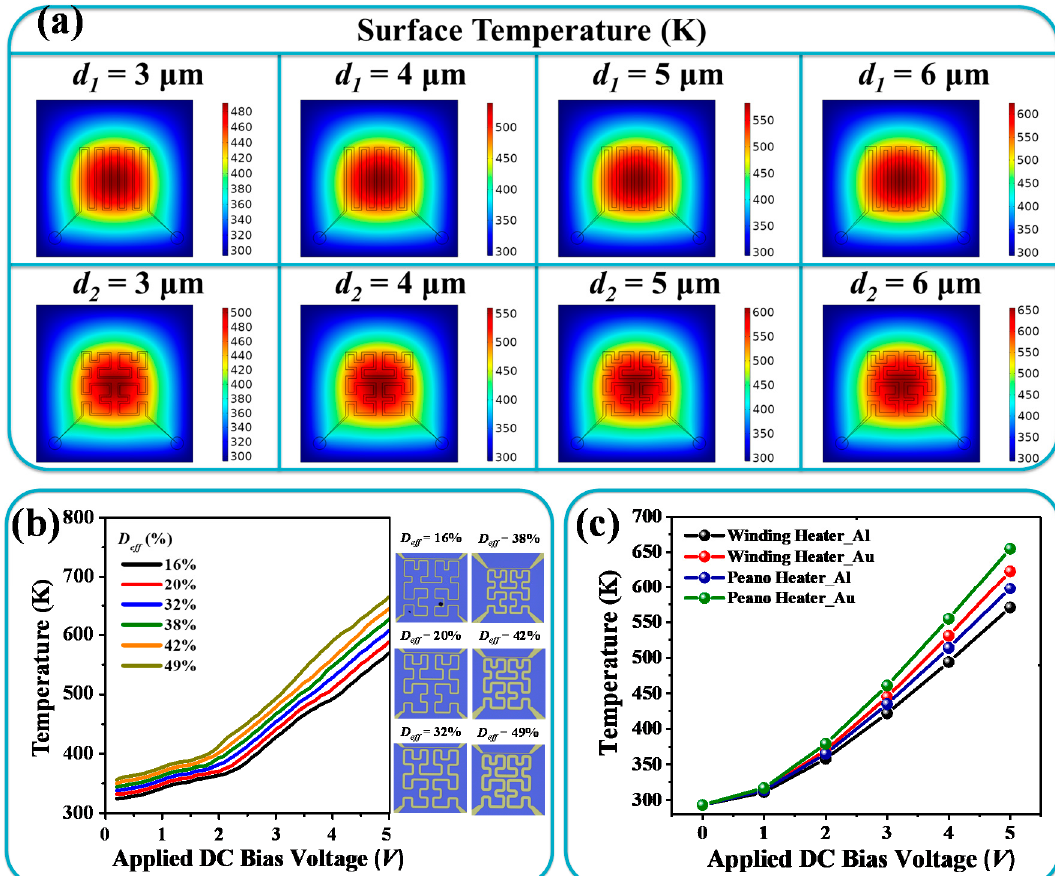
Figure 3. ( a ) Surface temperature distributions of microheaters with metal linewidths of d 1 and d 2 . ( b ) Temperature as a function of driving voltage for six Peano-shaped microheater designs with different pattern density. ( c ) Relationships between applied DC bias voltage and maximum surface temperature for winding microheaters and Peano-shaped microheaters. Corresponding materials are selected as Al and Au.